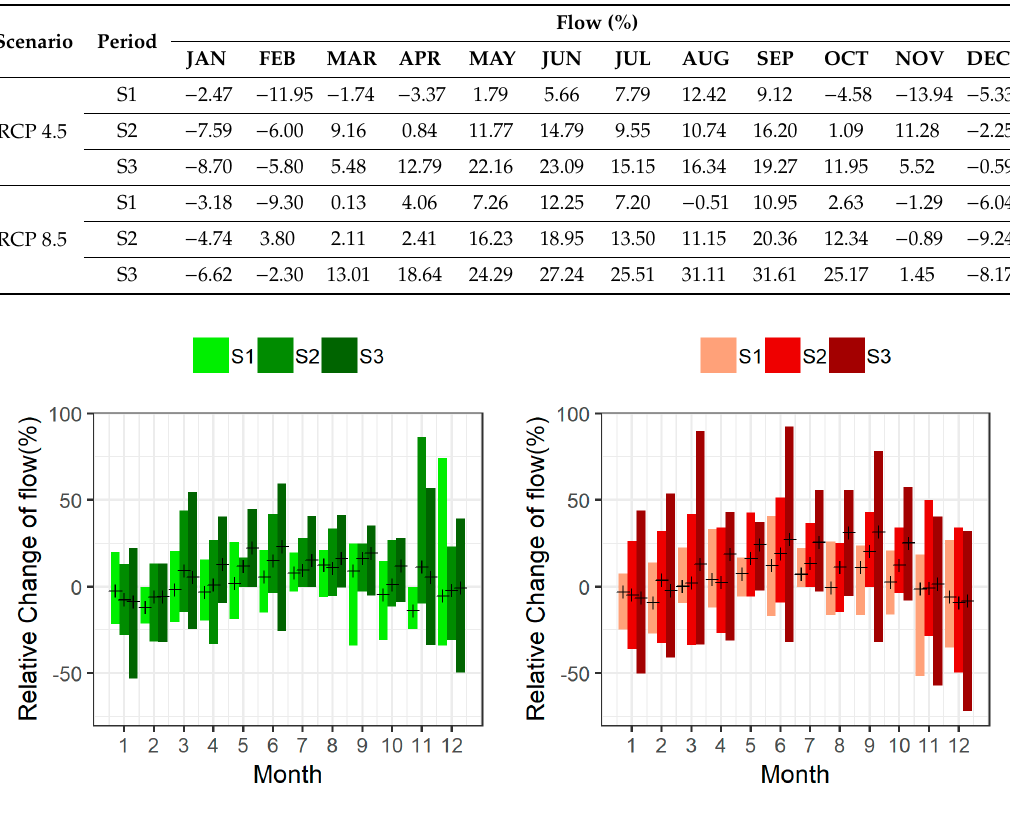
Figure 8. Relative change (%) of the 30-year average monthly flow compared with the reference period (1976–2005) for the RCP scenarios 4.5 and 8.5 using 13 GCMs in South Korea. The values in this figure were calculated by first converting daily flow data into monthly flow data. Next, the relative change of the 30-year average monthly flow for 13 GCMs was calculated and is shown as a box plot.